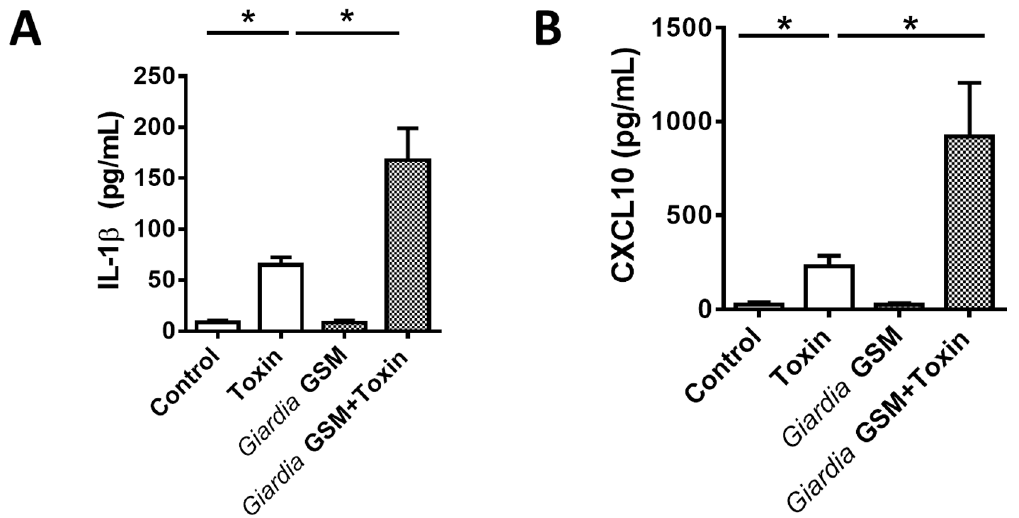
Figure 5. Giardia GS/M infections increase colonic expression levels of IL-1 b and CXCL10 following administration of C.difficile TcdAB. Male C57BL/6 mice, aged 4 to 6 weeks, were infected with Giardia GS/M trophozoites. 7 days post-infection, animals were given 100 m g of TcdAB or PBS i.r. and, after 3 hours, animals were euthanized. Levels of (A) IL-1 b and (B) CXCL10 were compared between Giardia GS/M-infected animals and uninfected animals given i.r. 100 m g of TcdAB or PBS. Values were determined via bead-based cytokine assay. All data are representative of two independent experiments (n=5–11/group) and represented as mean 6 SEM. * p , 0.05.